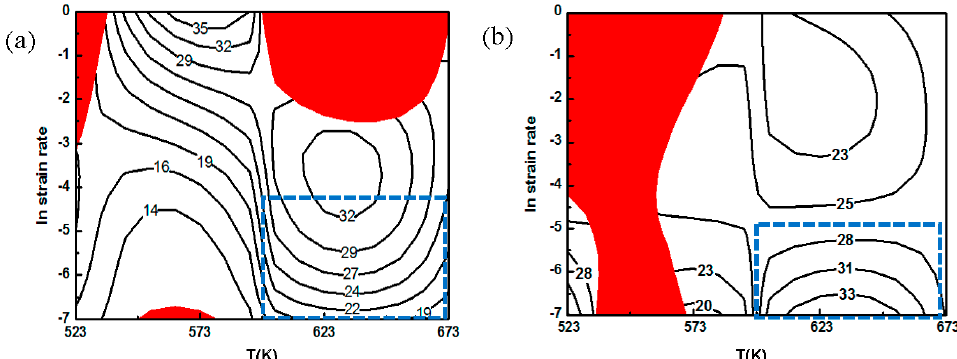
Figure 13. Processing maps of the AZ91 alloy and nano-SiCp/AZ91 composite at a strain of 0.5: ( a ) AZ91; ( b ) nano-SiCp/AZ91 composite [12].